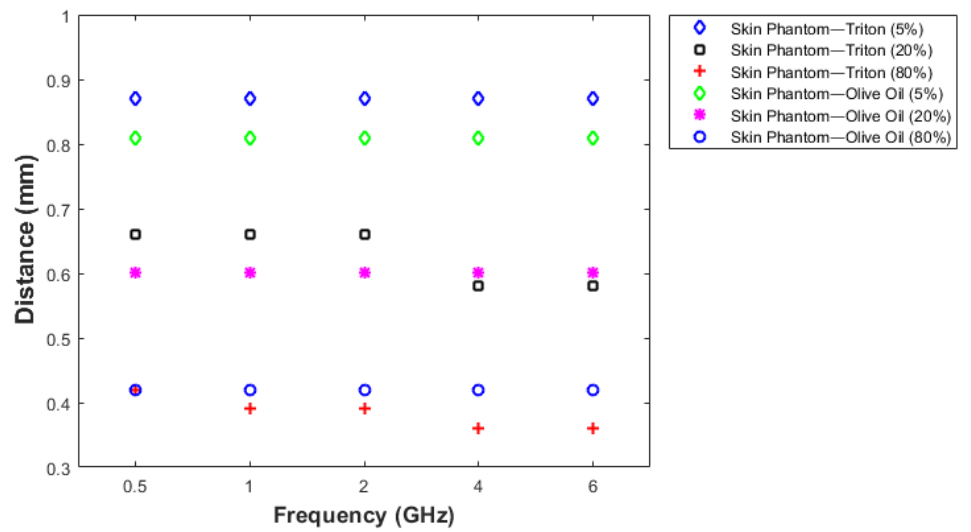
Figure 13. Skin–triton X-100 and skin–olive oil 5, 20 and 80% increase in relative permittivities at 0.5, 1, 2, 4 and 6 GHz frequency points.